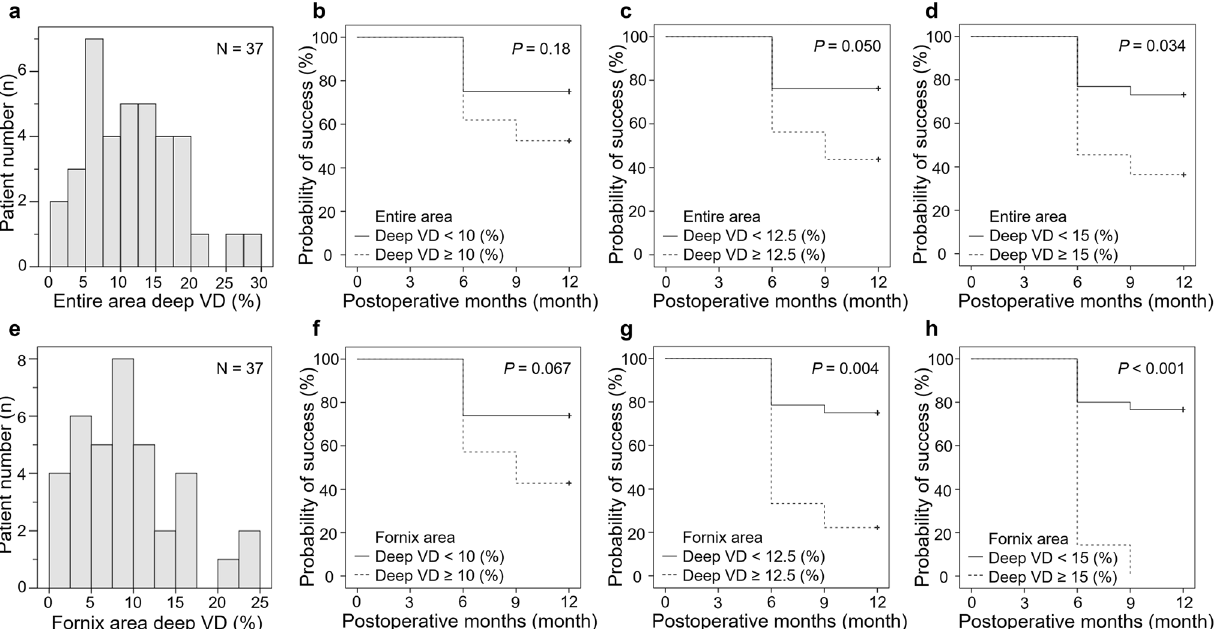
Figure 2. Kaplan–Meier cumulative survival curves of surgical success of two groups divided based on deep vessel density (VD) in the entire area and fornix area. ( a ) Histogram of the deep VDs in the entire area. ( b,c,d ) Kaplan–Meier cumulative survival curves of surgical success in the low VD group and high VD group classified according to the deep VD value ( b : 10%; c : 12.5%; d : 15%) in the entire area. The low VD group had a higher success rate than the high VD group ( d ) ( P = 0.034). ( e ) Histogram of the deep VDs in the fornix area. ( f,g,h ) Kaplan–Meier cumulative survival curves of surgical success in the low VD group and high VD group classified